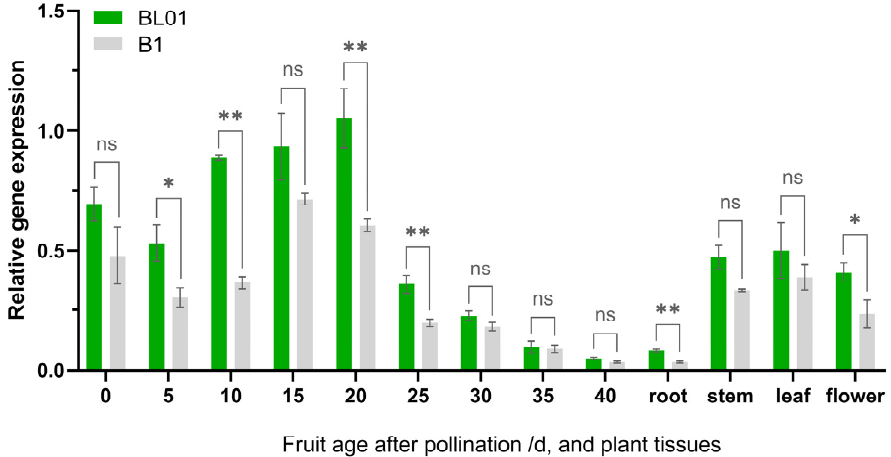
Figure 4. SmAPRR2 expression analysis. Expression analysis of SmAPRR2 in fruit peel and different issues of BL01 and B1. * 0.01 < p < 0.05; ** p < 0.01. “ns” means no significant difference. Green bars show the SmAPRR2 expression of green-skinned eggplant (BL01) and gray bars show that of white-skinned eggplant (B1).